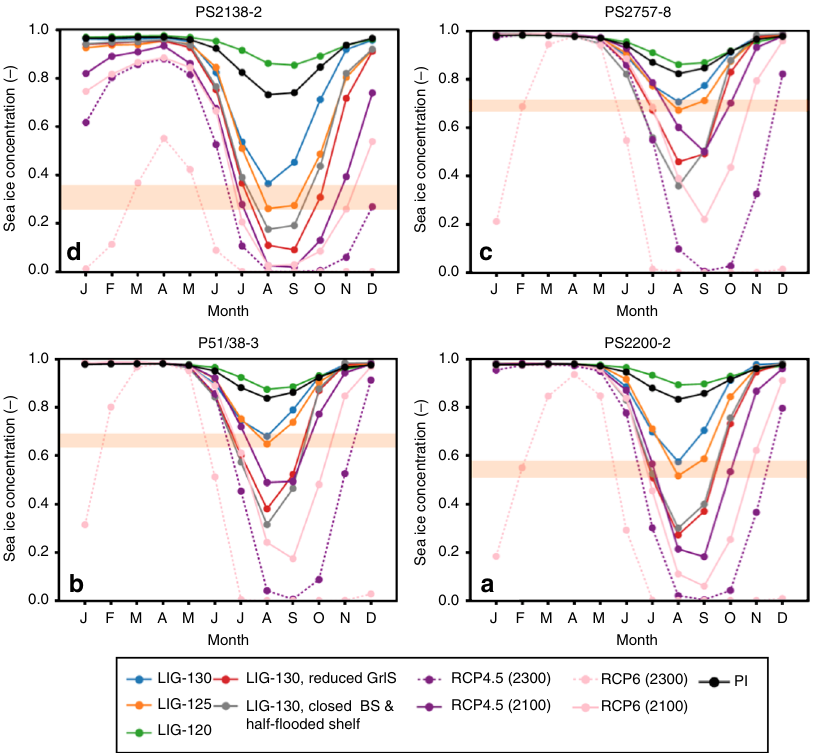
Fig. 8 Modeled monthly sea ice concentrations at the four different core locations. For a Core PS2200-2, b Core PS52/38-3, c Core PS2757-8, and d Core PS2138-2 simulation results for the Last Interglacial ( LIG ) phases at 130, 125, and 120 ka as well as the Pre-Industrial ( PI ) climate are presented. Additionally, we show results from a sensitivity study with a reduced Greenland Ice Sheet (GrIS) at 130 ka 28 and for a 130 ka scenario with a closed Bering Strait ( BS ) and half- fl ooded Siberian shelf seas (Supplementary Fig. 9) as well as for future (2300 and 2100) scenarios following the IPCC Representative Concentration Pathway (RCP) scenarios RCP4.5 (583 ppm CO 2eq ) and RCP6 (808 ppm CO 2eq ) 2, 27 . Horizontal orange bars highlight summer sea ice minima of the LIG-125 and LIG-130 scenarios